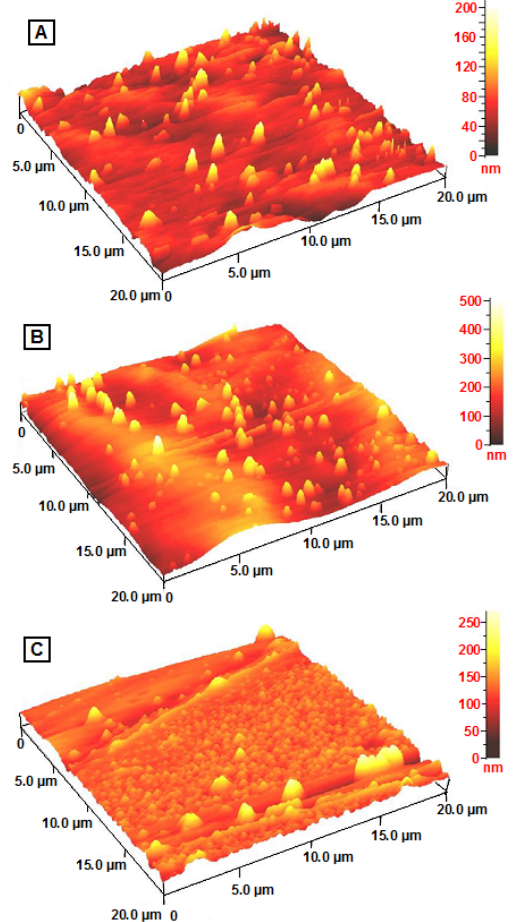
Figure 5. AFM images of the surface topography of Ag/Cts ( A ); Ag/Cts/gelatin ( B ); and Ag/gelatin ( C ) thin films.